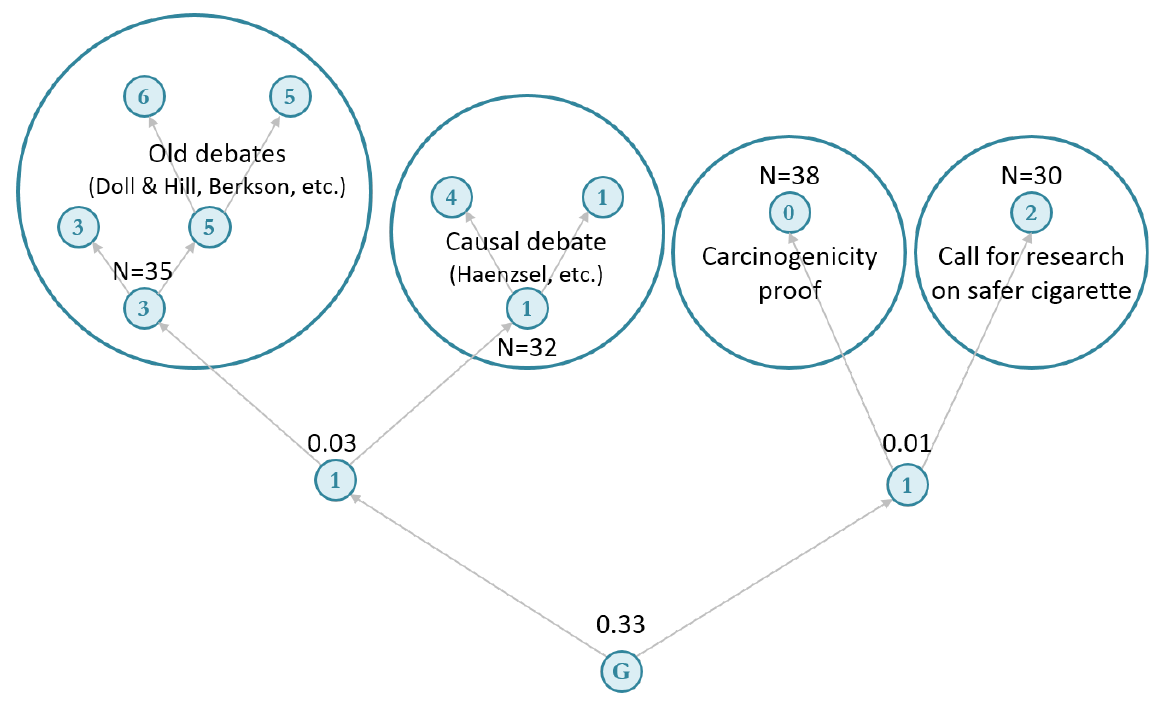
Figure 2: Communities in the 1965 Citations Network. Community numbers are arbitrary. Decimal fractions refer to the division’s contribution to overall raw modularity, and N refers to the number of scientific articles in every final community—indivisible or where further divisions’ modularity contribution is less than